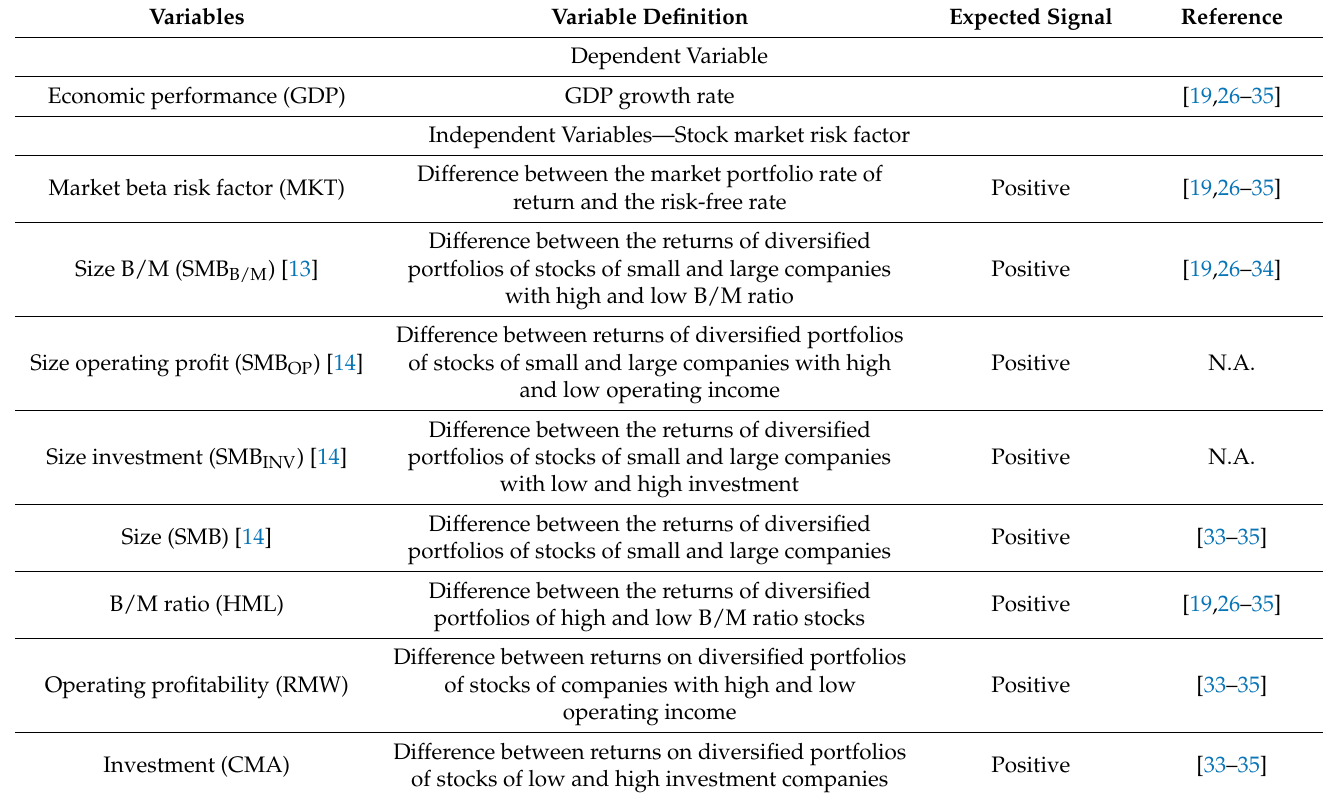
Table 2. Variables definition and the expected relationship according to the literature